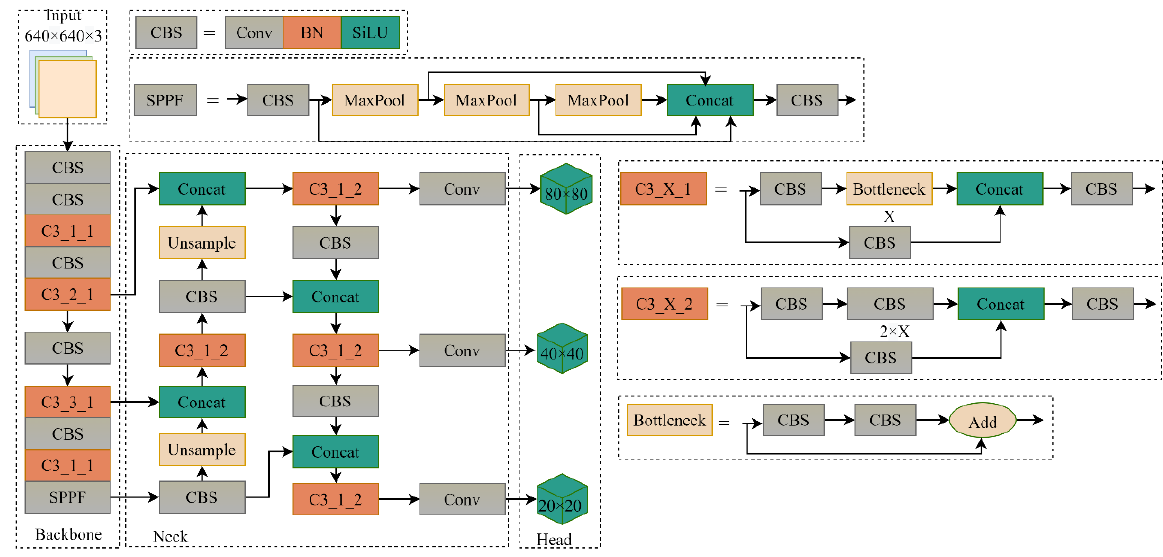
Figure 1. Structure of